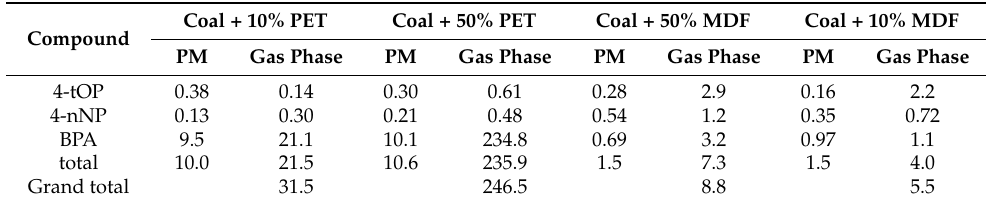
Table 4. Alkylphenol emission factors (mg/h).